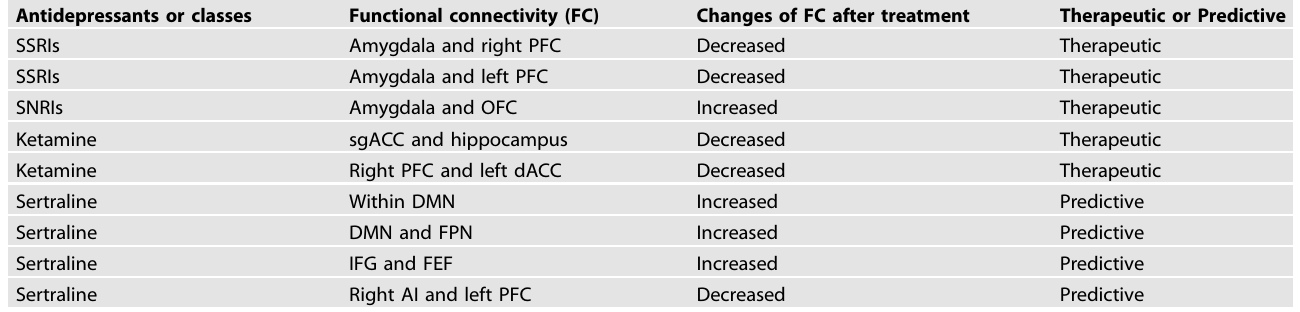
Table 2. Changes of brain functional connectome in MDD patients in response to antidepressant